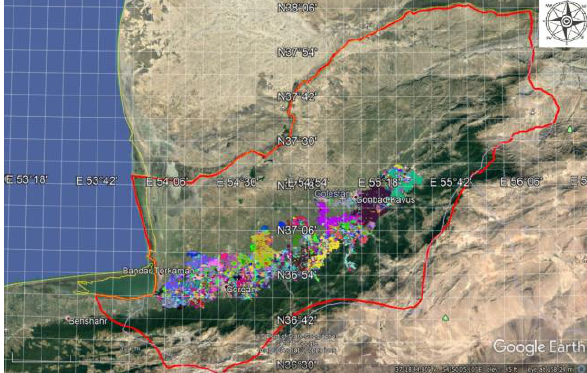
Figure 3. Clustering the study of area based on the same cultivation